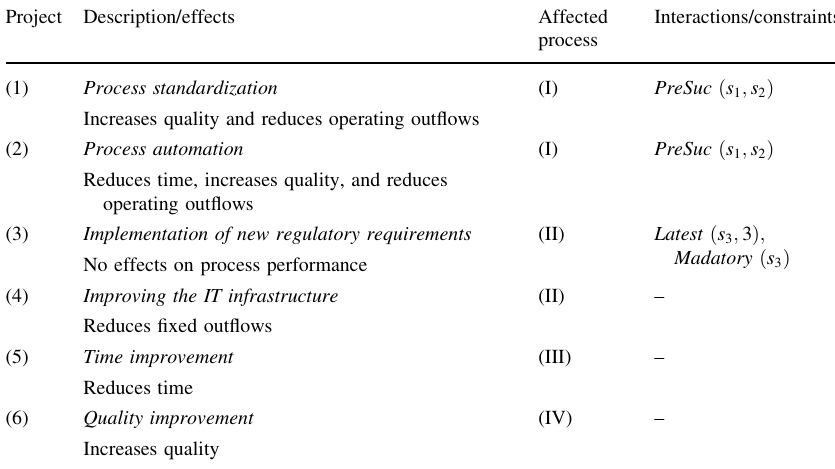
Table 5 Process-level projects considered in the case Project Description/effects